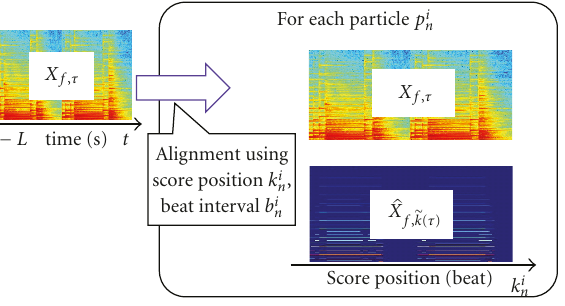
Figure 4: Weight calculation for pitch